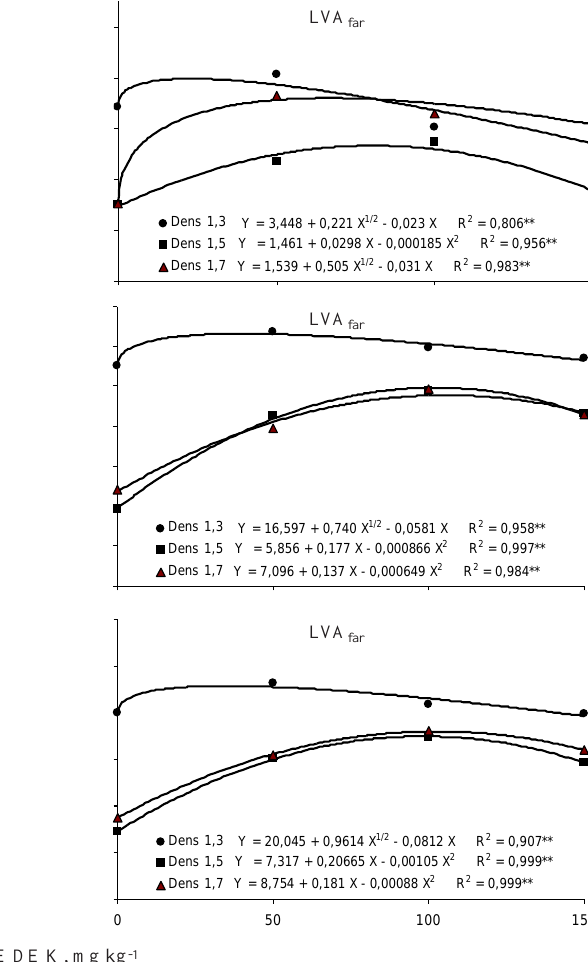
Figura 1. Matéria seca de raiz, parte aérea e total de plantas de E. camaldulensis , cultivadas em dois Latossolos de texturas muito argilosa (LV doses de